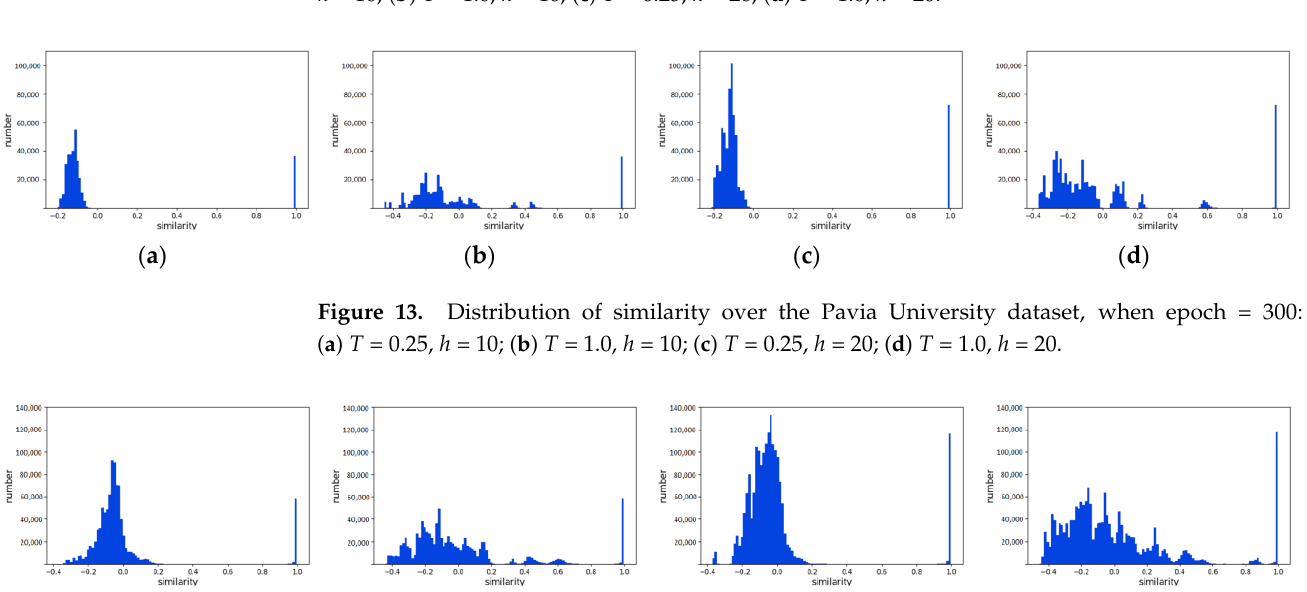
Figure 12. Distribution of similarity over the Indian Pines dataset, when epoch = 300: ( a ) T = 0.25, h = 10; ( b ) T = 1.0, h = 10; ( c ) T = 0.25, h = 20; ( d ) T = 1.0, h = 20.